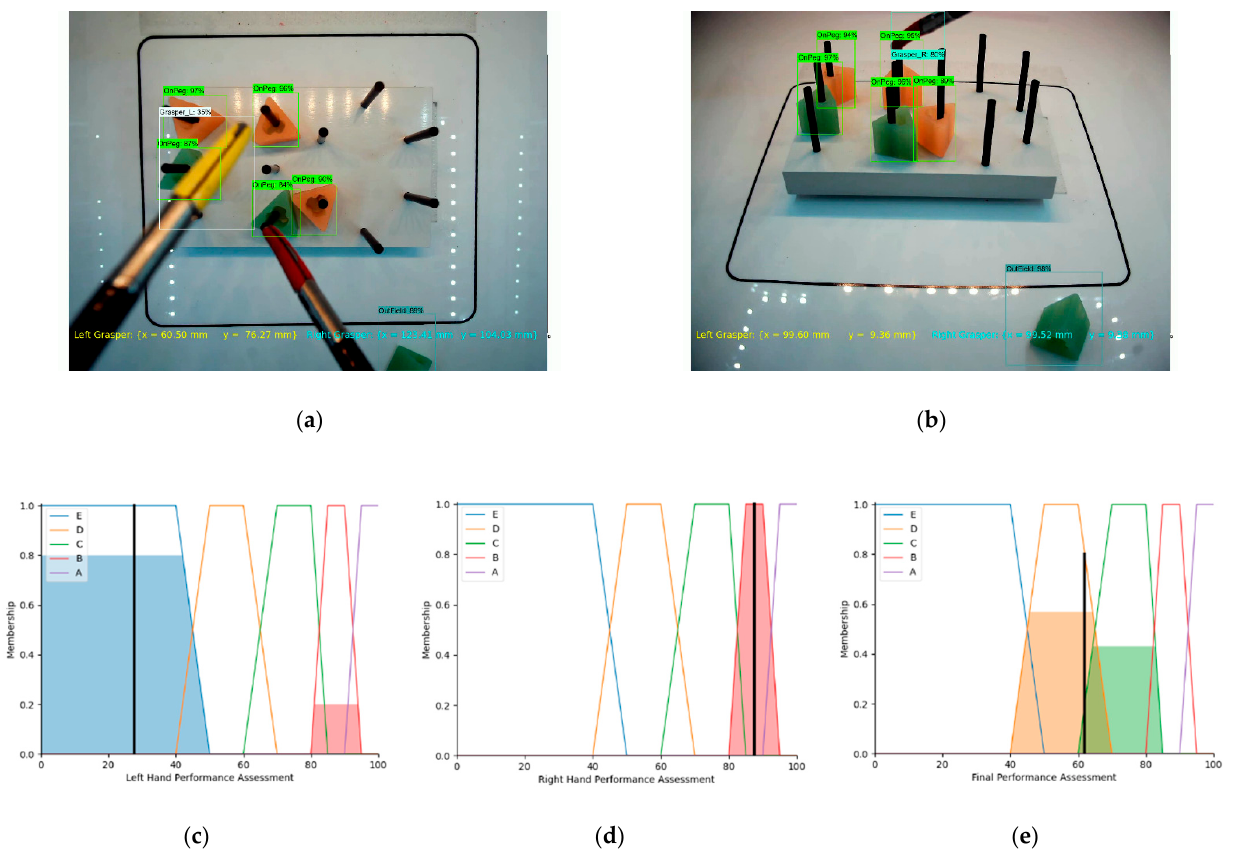
Figure 11. ( a , b ) Object detection and measurement metric results for top and front cameras, ( c )